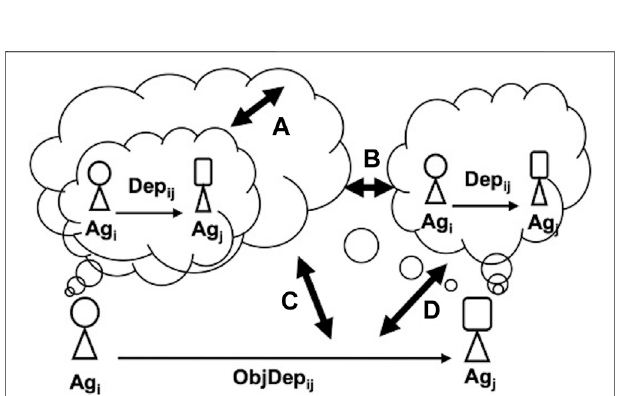
FIGURE 7 | Dependence of Ag i from Ag j on the task τ . (A) comparison on how it is believed by Ag i and how Ag j believes it is believed by Ag i ; (B) comparison on how it is believed by Ag j and the objective reality; (C) comparison on how Ag j believes it is believed by Ag i and how it is believed by Ag j ; (D) comparison on how Ag j believes it is believed by Ag i and the objective reality.